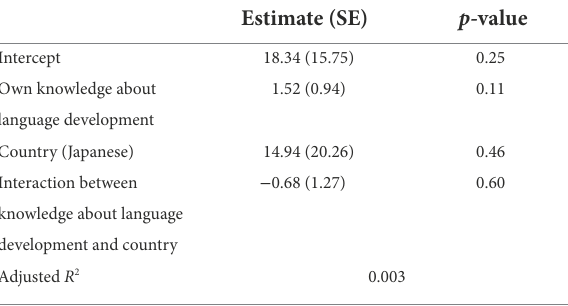
TABLE 13 The linear regression model predicting educators’ own worry about children’s